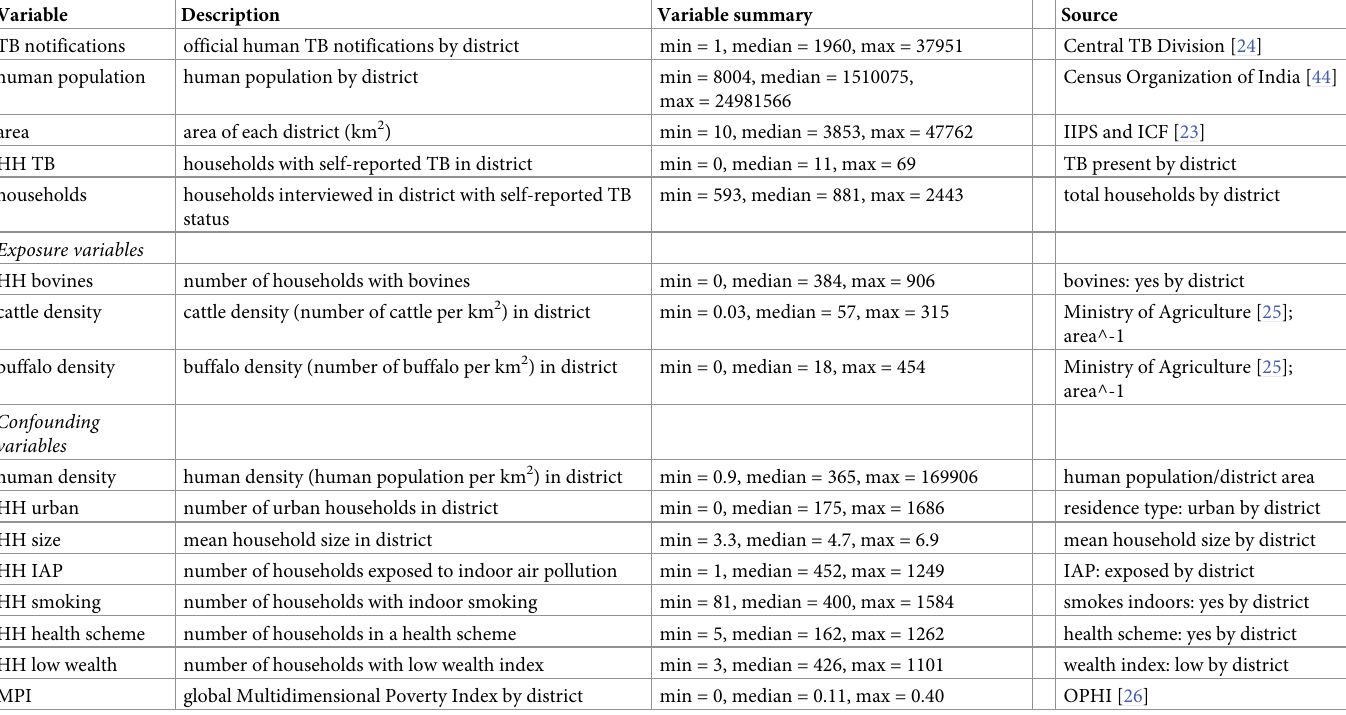
Table 2. Description and summary statistics of variables considered for the two district level models of human tuberculosis in